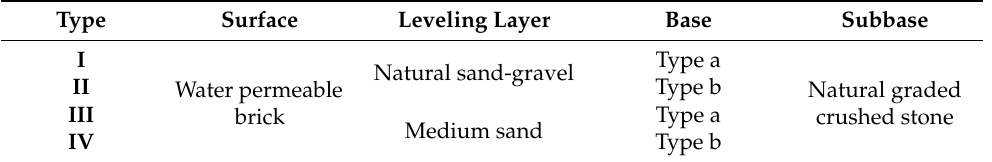
Figure 2. Precast concrete components: ( a ) type a; and ( b ) type b. Table 1. Design of four types of prefabricated permeable pavements.